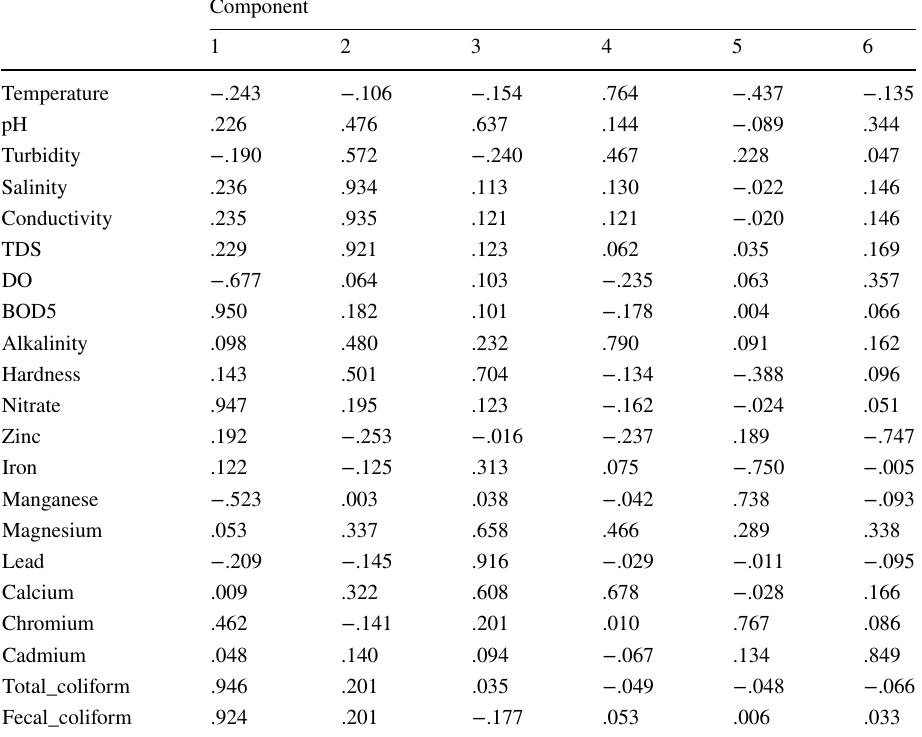
Table 7 Rotated component matrix